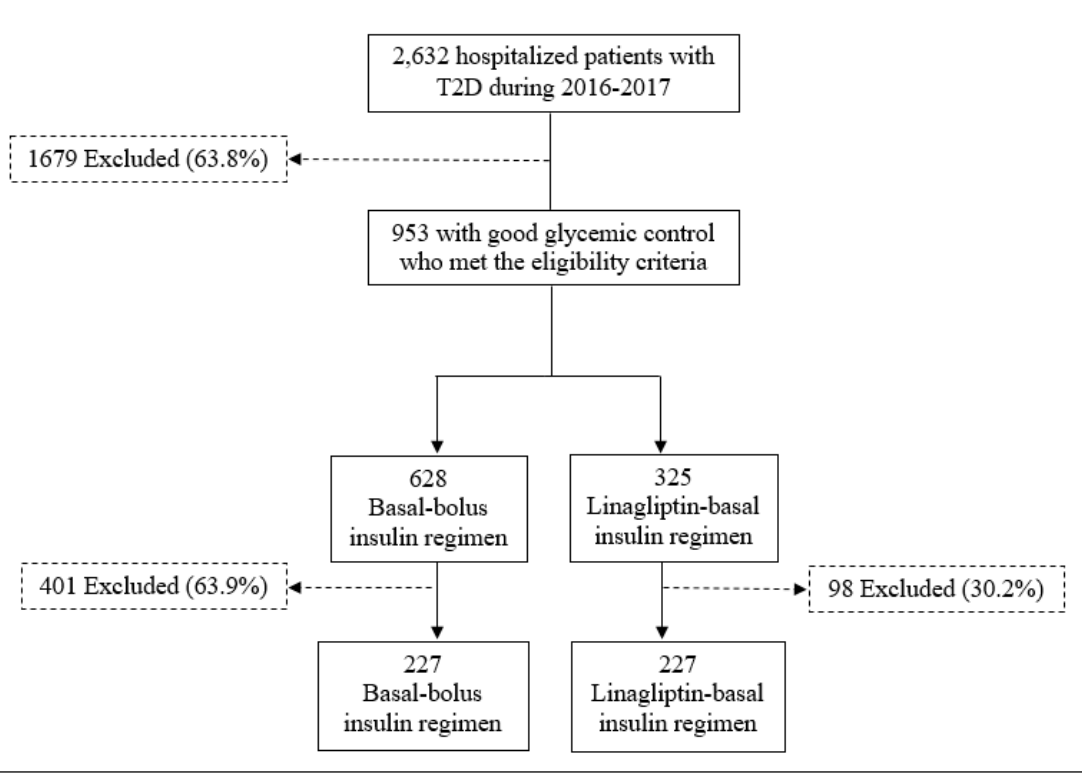
Figure 1. Patient flow charts for basal-bolus versus DPP4i-basal regimen. T2D: Type 2 Diabetes .